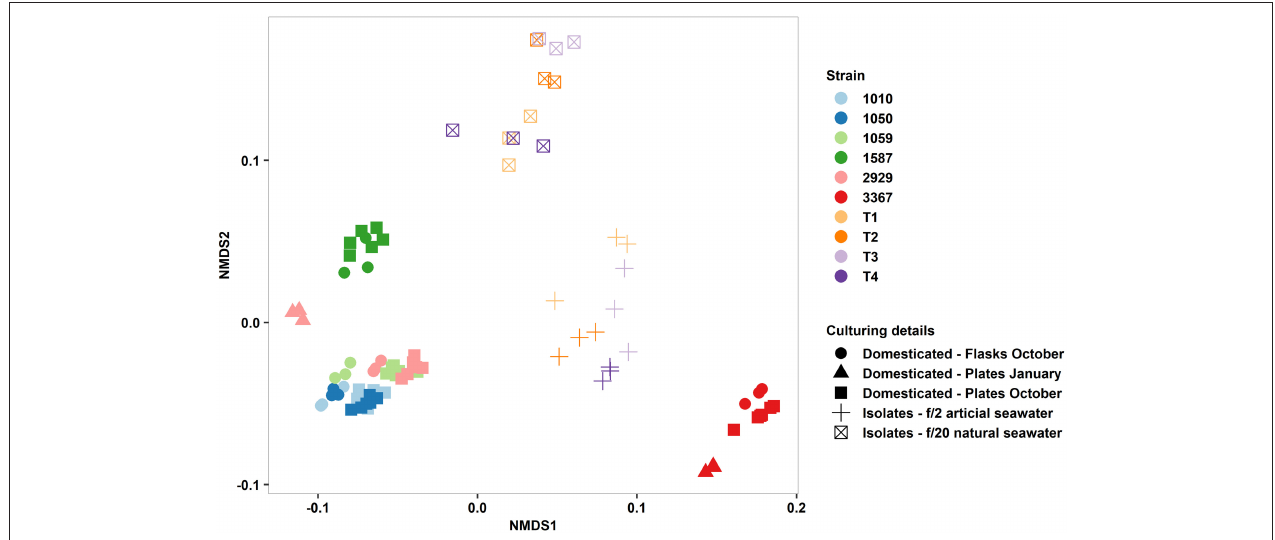
FIGURE 6 | Non-metric multidimensional scaling plot of multi-trait phenotypes of domesticated Thalassiosira strains (CCMP1010, CCMP1050, CCMP1059, CCMP1587, CCMP2929, and CCMP3367) and newly established isolates from Port Hacking, Sydney, Australia (T1–4). Input traits were: Growth rate, cell size, granularity, Chl-A, Lipid content, ROS content, alpha, ETRmax, and I k . Symbols represent type of strain, culture vessel, time of phenotyping, and culture media.